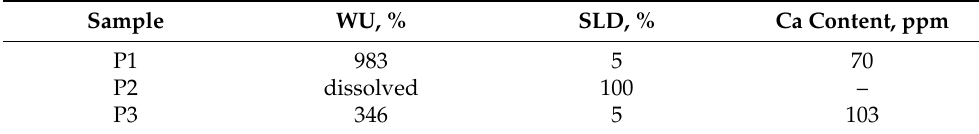
Table 2. Water-related properties of pectin-based